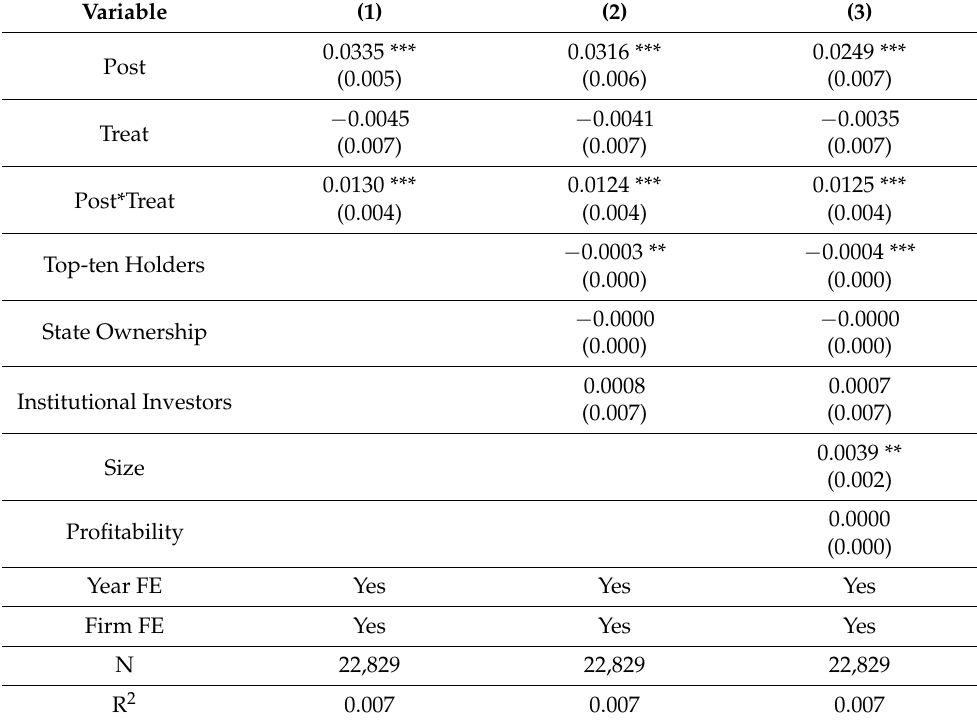
Table 5. Empirical test on the impact of green credit guidelines on corporate green